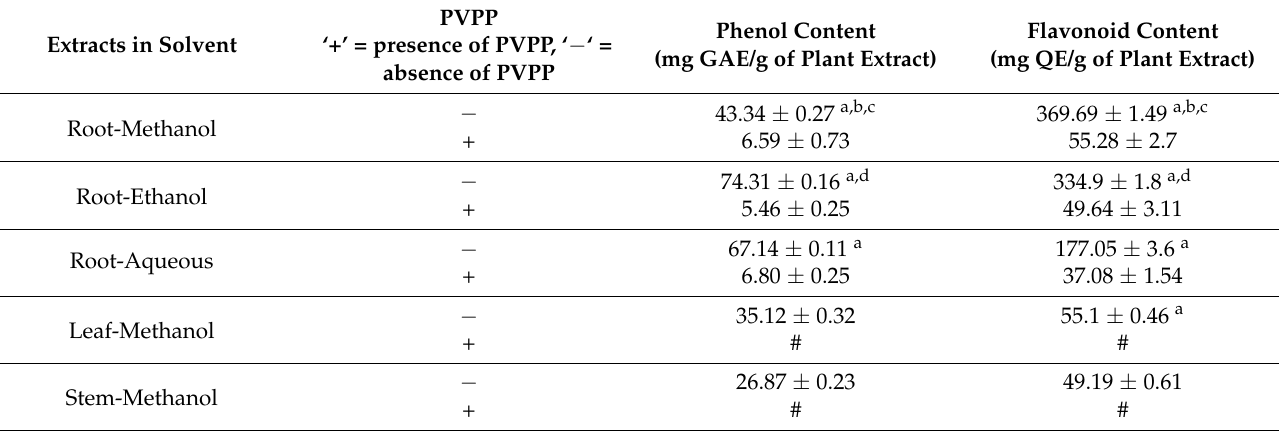
Table 3. Quantification of phenol and flavonoid contents in extracts of R . cordifolia